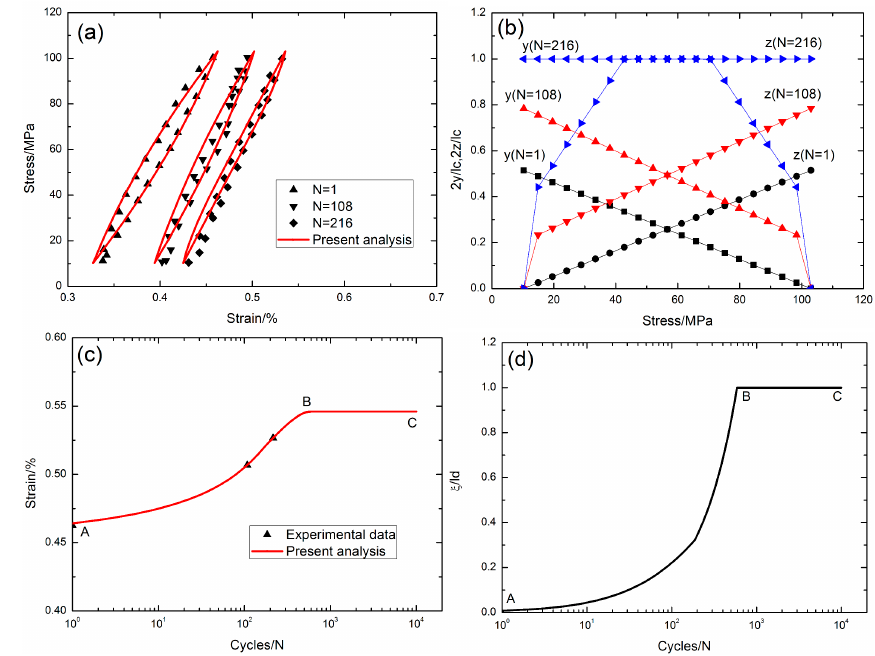
Figure 12. ( a ) The fatigue hysteresis loops corresponding to different applied cycles; ( b ) the interface slip lengths versus applied stress corresponding to different cycle numbers; ( c ) the peak strain versus cycle number curves; and ( d ) the interface oxidation length ξ / l d versus cycle number curves of cross-ply SiC/MAS composite under σ max = 103 MPa at 1093 °C with stress rupture time of t = 10 s.